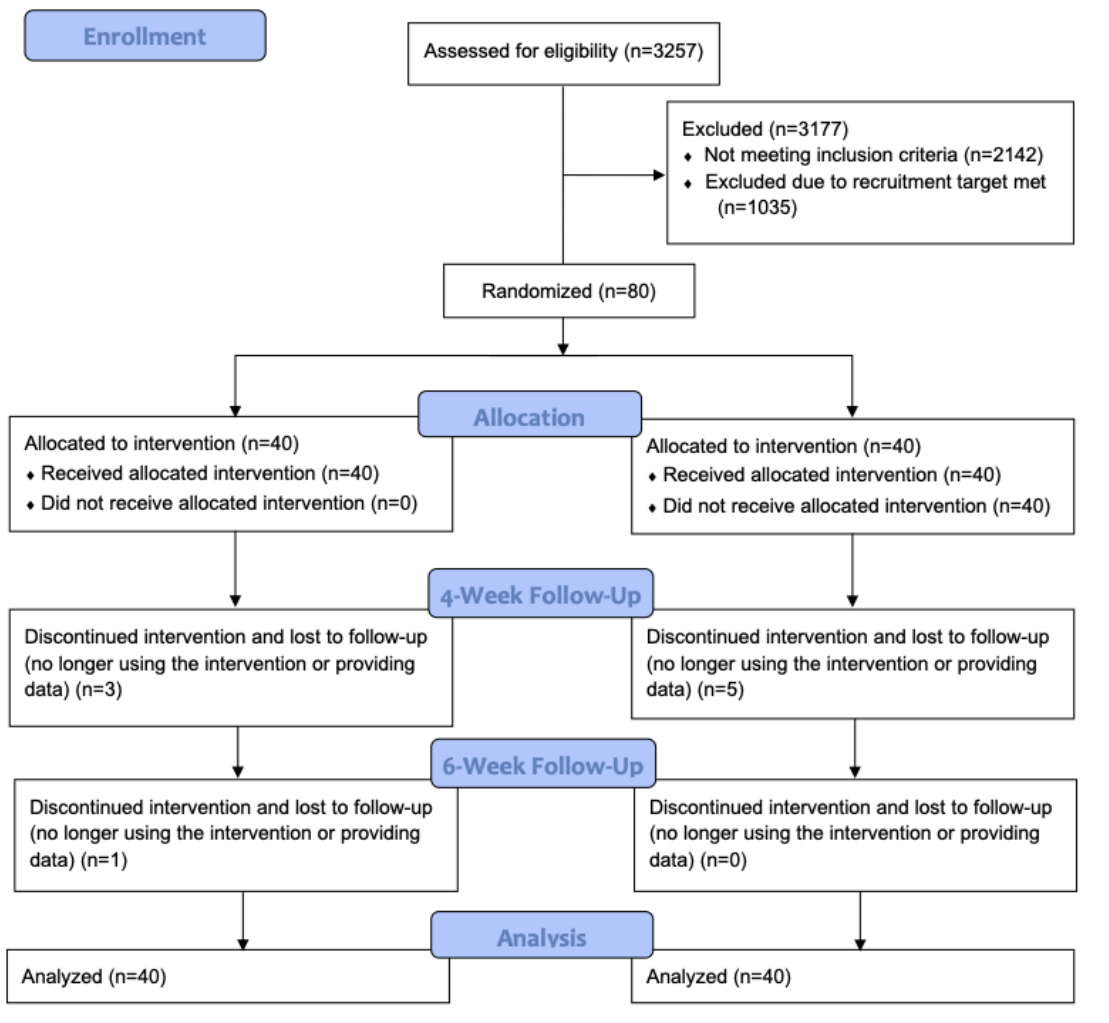
Figure 1. Flowchart of trial recruitment, enrollment, and